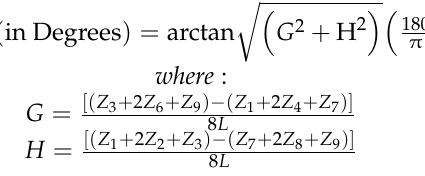
Figure 3. Histograms of pixel values for image layers ( A ) slope, ( B ) topographic position index, ( C ) curvature, and ( D ) unenhanced thermal imagery, Pisgah Lava Field, Mojave Desert, CA, USA. For both slope [79,80] and curvature [81], we used standard ArcGIS algorithms. Given a 3 × 3 neighborhood, with cell values identified as Z 1 . . . Z 9 , and Z 5 being the central cell, and with L = cell edge length, slope is the standard first derivative (the rate of change of thermal values; Equation (1) in the direction of the greatest rate of